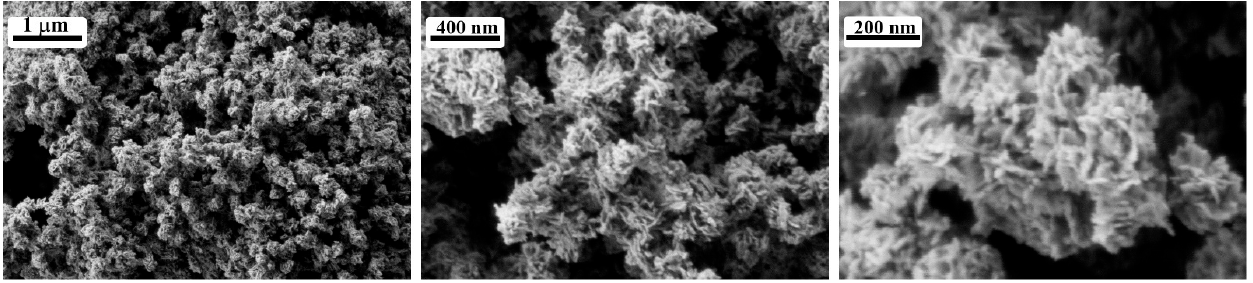
Figure 4. Diffractogram for V 2 O 5 film on Pt/Al 2 O 3 /Pt chip. SEM results (Figure 5) indicate that the resulting oxide film, as well as the source powder, consists of hierarchically assembled structures based on nanosheets. The film is uniform, does not have any deficiencies such as cracks or delamination, and possesses heightened porosity. The mean size of these agglomerates is 200 ± 15 nm, which correlates well with the utilized oxide powder. No admixtures with microstructure differing from the one exhibited by vanadium (V) oxide particles were found in the film.